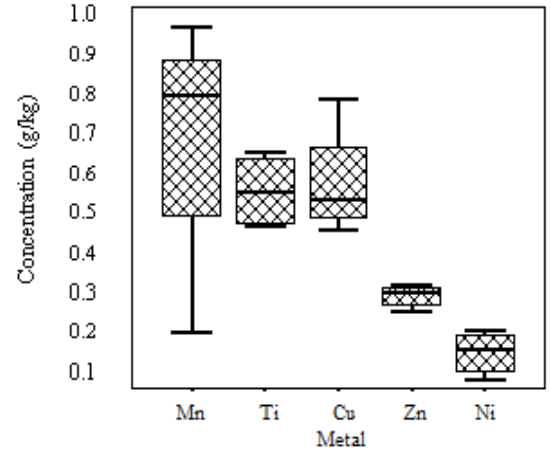
Figure 1. Statistics of Mn, Ti, Cu, Zn and Ni content in EMHS.